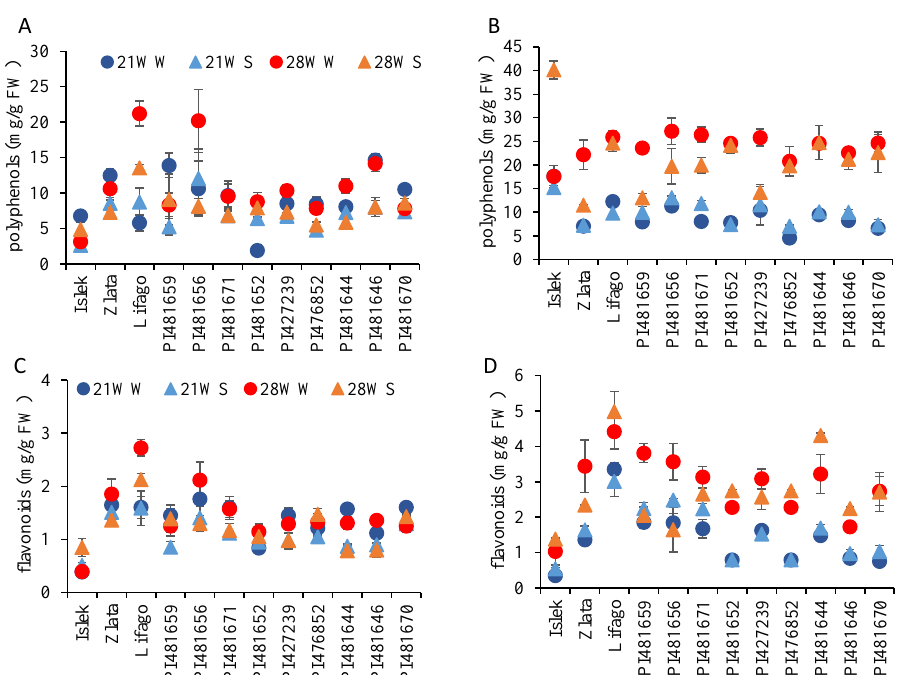
Figure 7. Antioxidant content of F. tataricum varieties subjected to two temperatures (21 ◦ C vs. 28 ◦ C) and water supply conditions (well-watered vs. water-stressed). ( A , B ) Total polyphenol concentration and ( C , D ) total flavonoid concentrations in leaves ( A , C ) and inflorescences ( B , D ). 21WW: 21 ◦ C well-watered, 21WS: 21 ◦ C water stress, 28WW: 28 ◦ C well-watered, 28WS: 28 ◦ C water